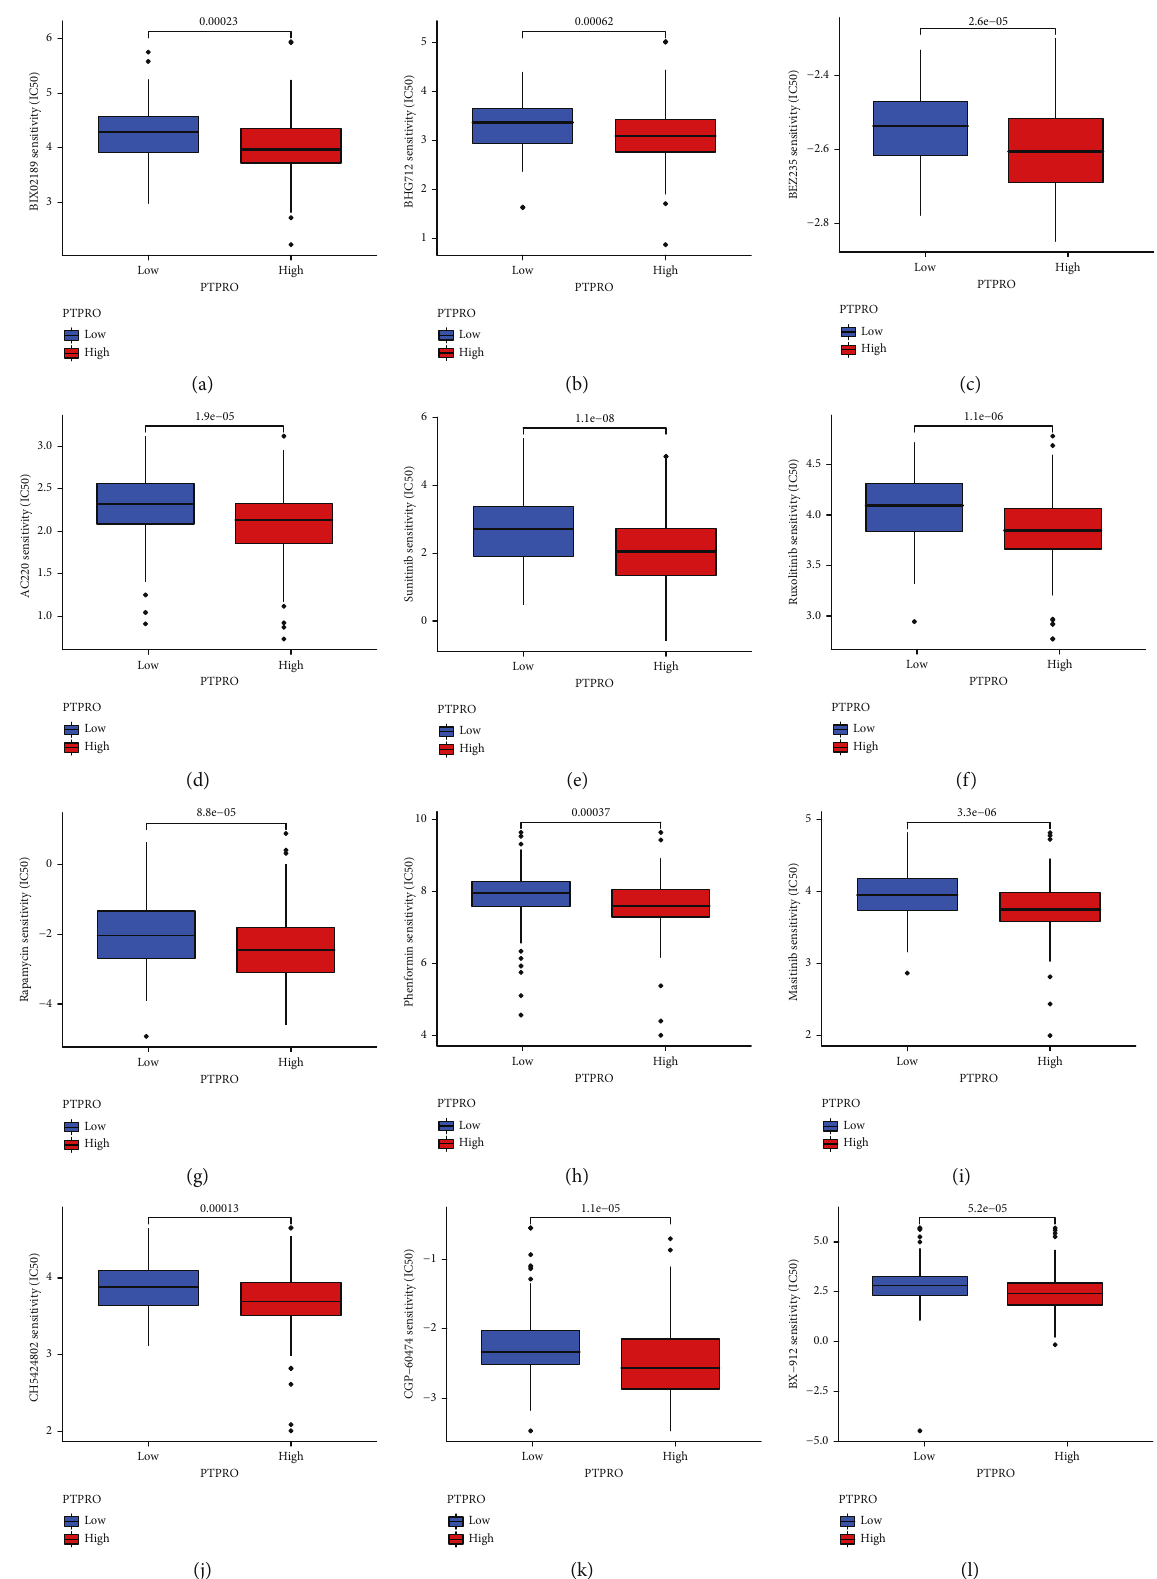
Figure 7: Prediction of sensitivity to chemotherapeutic drugs based on PTPRO expression levels. (a – l) Prediction of PTPRO expression levels in LUAD for sensitivity to multiple